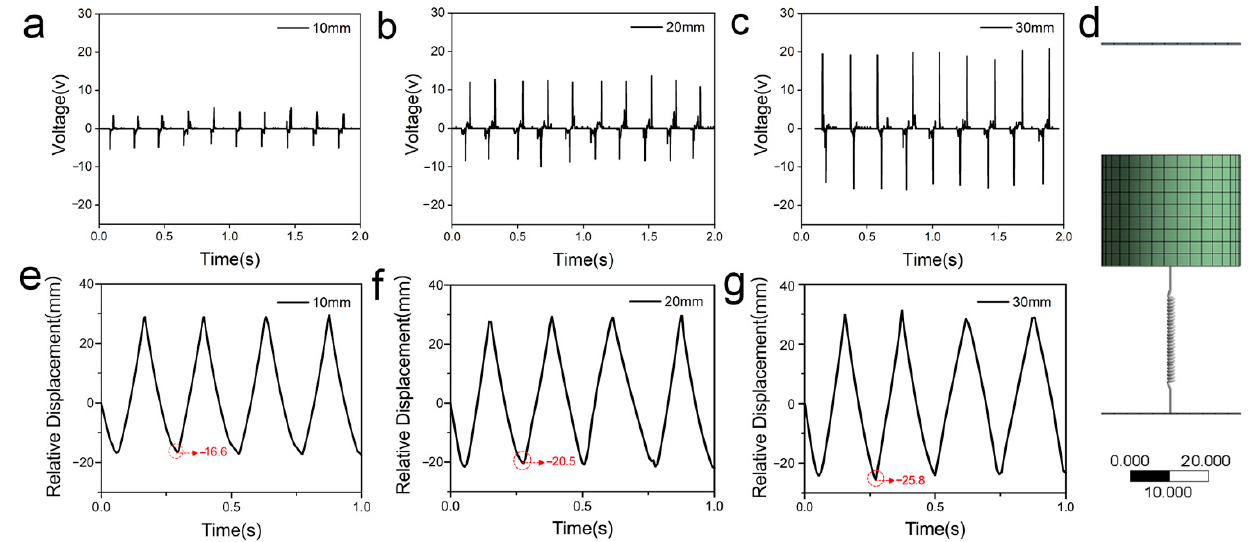
Figure 2. Output voltage signals and relative displacement at different vibration amplitude from 10 mm to 30 mm and same frequency of 4 Hz. ( a ) Output voltage signal when the vibration amplitude is 10 mm. ( b ) Output voltage signal when the vibration amplitude is 20 mm. ( c ) Output voltage signal when the vibration amplitude is 30 mm. ( d ) Simulation model of S-TENG. ( e ) Relative displacement when the vibration amplitude is 10 mm. ( f ) Relative displacement when the vibration amplitude is 20 mm. ( g ) Relative displacement when the vibration amplitude is 30 mm.